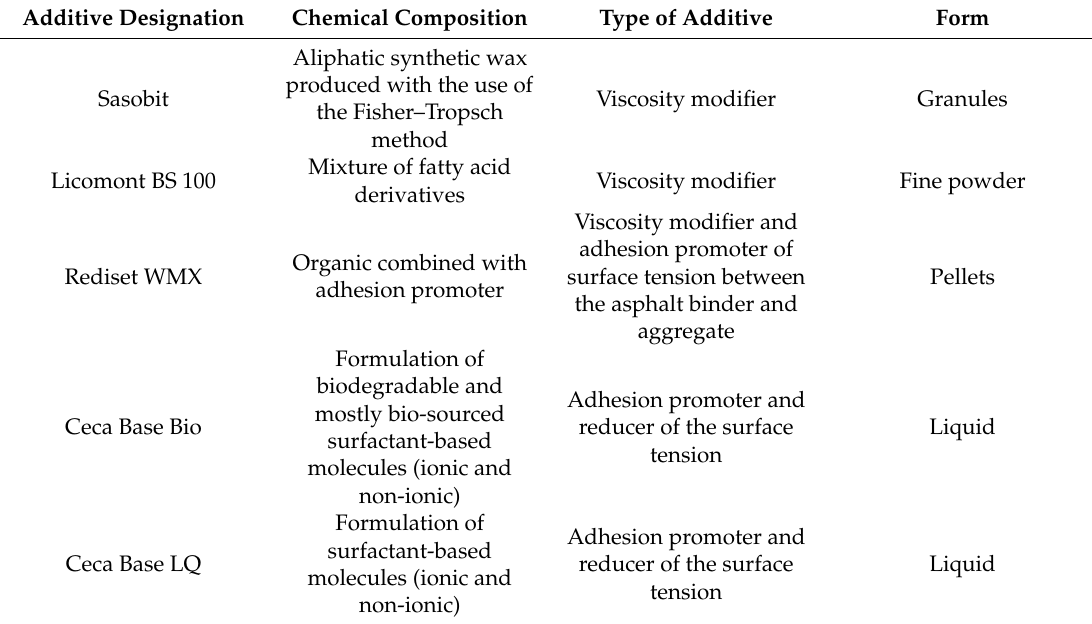
Table 1. Description of warm mix asphalt additives used in the